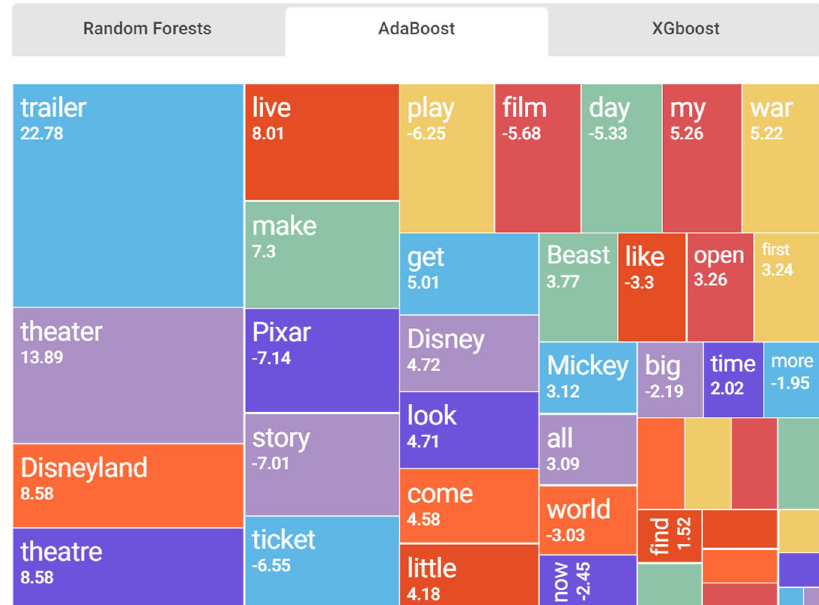
Fig. 4 Disney cues high weighting of Adaboost, in the form of likes are day, Pixar, Disneyland, story, and history as highlighted by